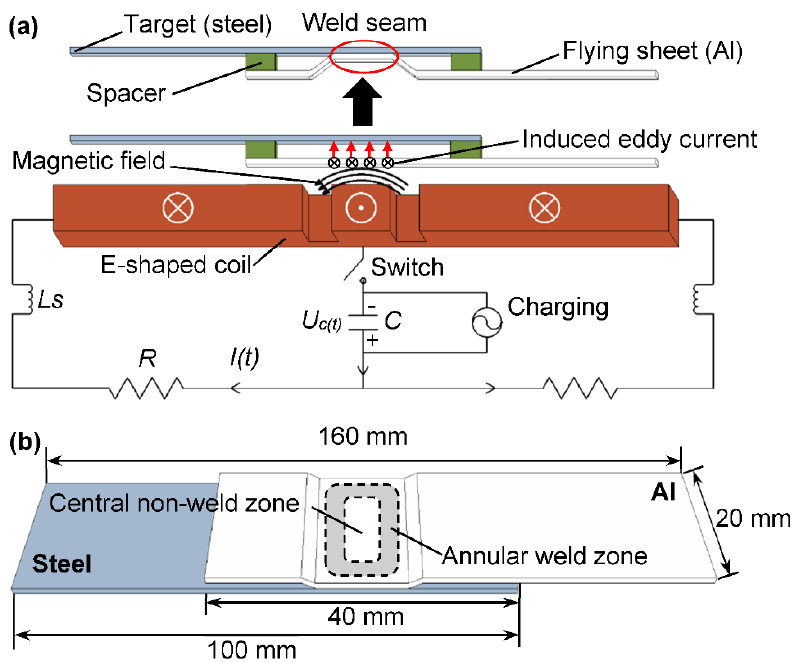
Figure 1. Schematic diagram of electromagnetic pulse welding (EMPW) process of Al–steel dissimilar materials. ( a ) Principle of EMPW; ( b ) dimensions and annular weld zone of a tensile lap shear test sample.